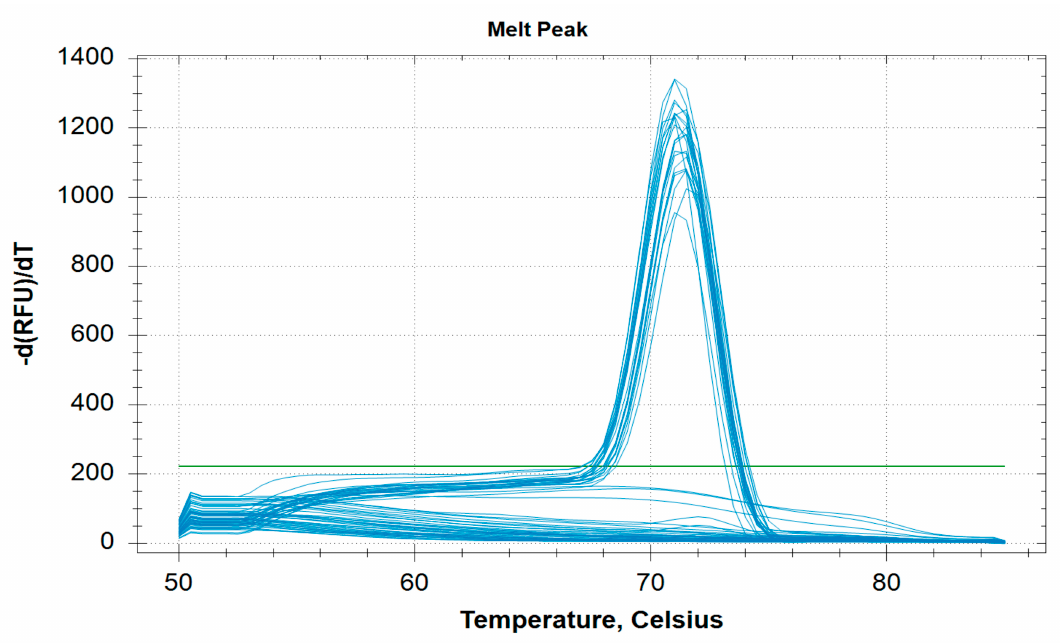
Figure 3. Melting curve analysis of clinical twenty clinical Pm samples with melting temperature (T m ) of 71 ◦ C ± 0.5 ◦ C. It is evident that individual mono-infection can be determined using the multiplex primer systems i.e., primers for Pf , Pv , and Pm in a single amplification reaction with T m of 74 ◦ C, 75 ◦ C, and 71 ◦ C respectively indicating mono-infection only (Figure 4). For every mono-infection, a distinct melting temperature was observed but co-infection could not be determined in all the run. This was consistent in both two and three primer multiplex system.